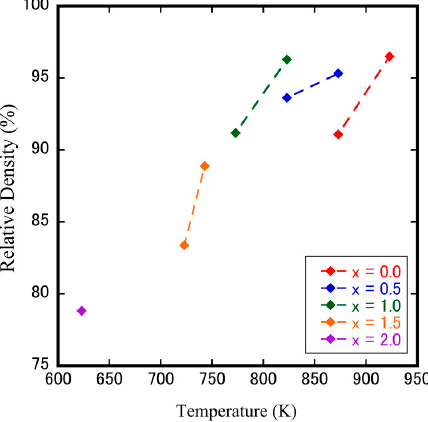
Figure 6. SEM micrographs of the fractured surface of cubic-ZrW 2 − x Mo x O 8 ceramics ( a ) x = 0.0 sin- tered at 923 K, ( b ) x = 0.0 sintered at 873 K, ( c ) x = 0.5 sintered at 873 K, ( d ) x = 1.0 sintered at 823 K, ( e ) x = 1.5 sintered at 743 K, ( f ) x = 2.0 sintered at 623 K, ( g ) SEM micrograph of the polished surface